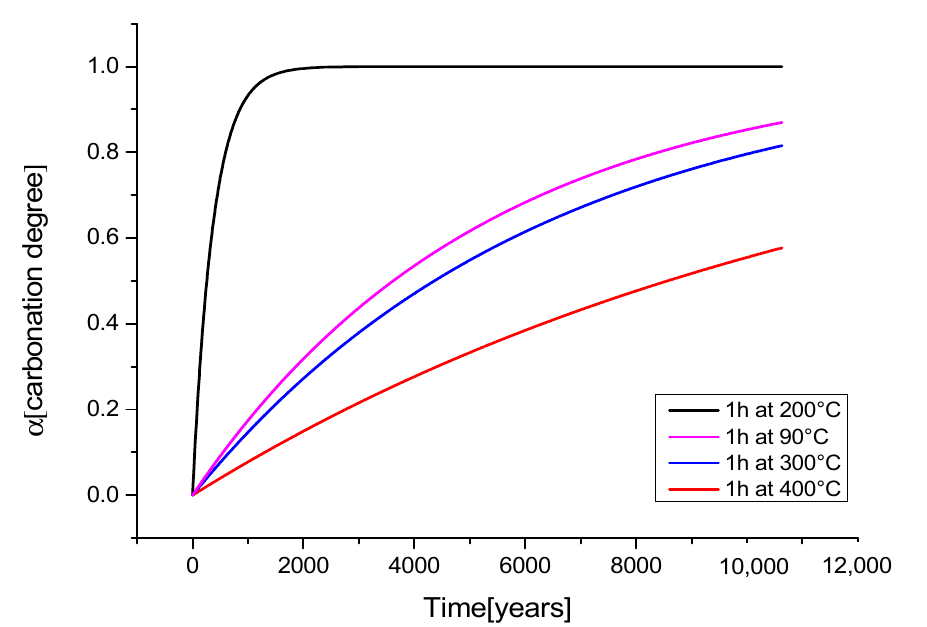
Figure 5. Calibrated fits using τ eq to obtain aging kinetic models pre-treated for 1 h at different temperatures.